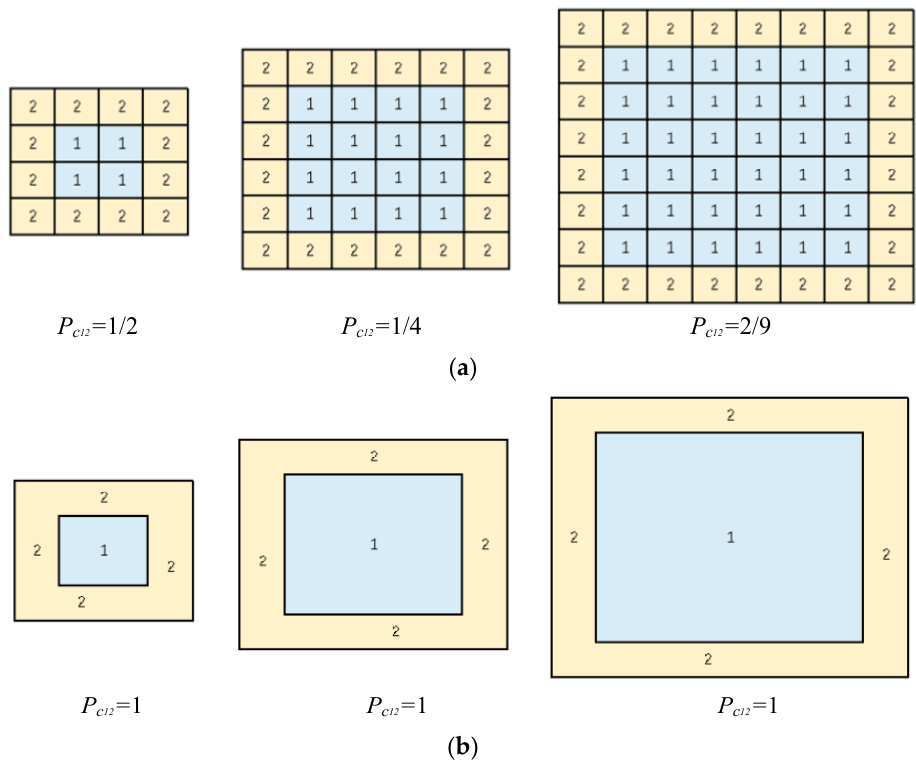
Figure 21. The object-oriented method for pre-classification was chosen based on whether the model uses ( a ) pixels for pre-classification or ( b ) objects for pre-classification. The object model is more robust compared to the pixel model, which makes the built graph more applicable to it.